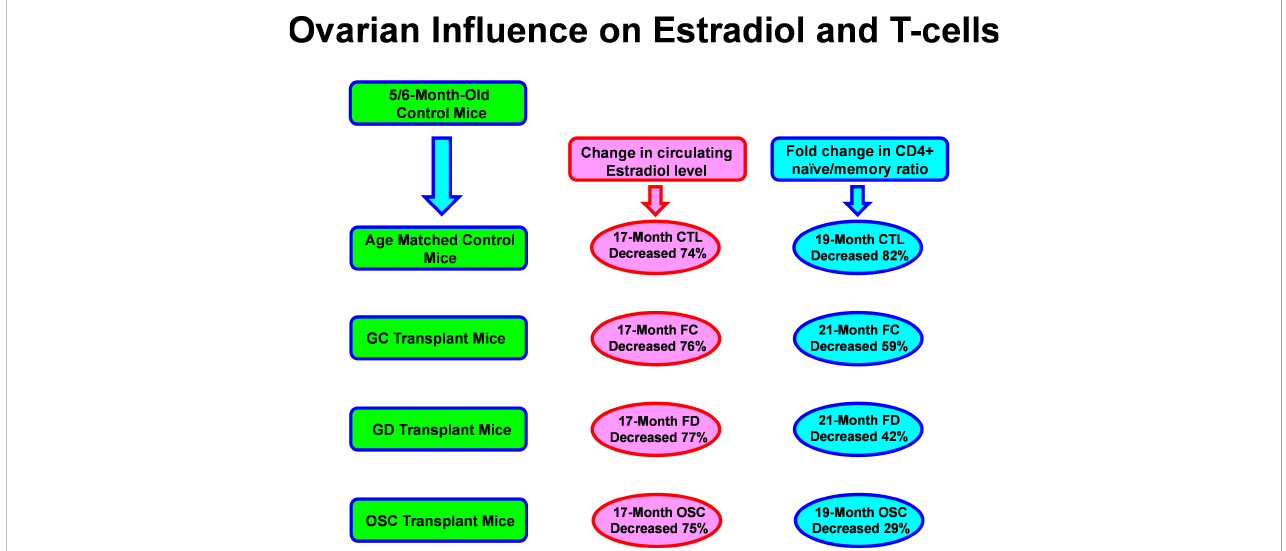
FIGURE 1 Aging and ovarian-associated changes in estradiol and T cell function. Estradiol remained low while T cell function improved with exposure to young ovarian tissue in aged female mice. FC, transplanted with follicle-containing young 60d ovaries at 13mo of age; FD, transplanted with follicle-depleted young 60d ovaries at 13mo of age; OSC, transplanted with isolated young 60d ovarian somatic cells at 13mo of